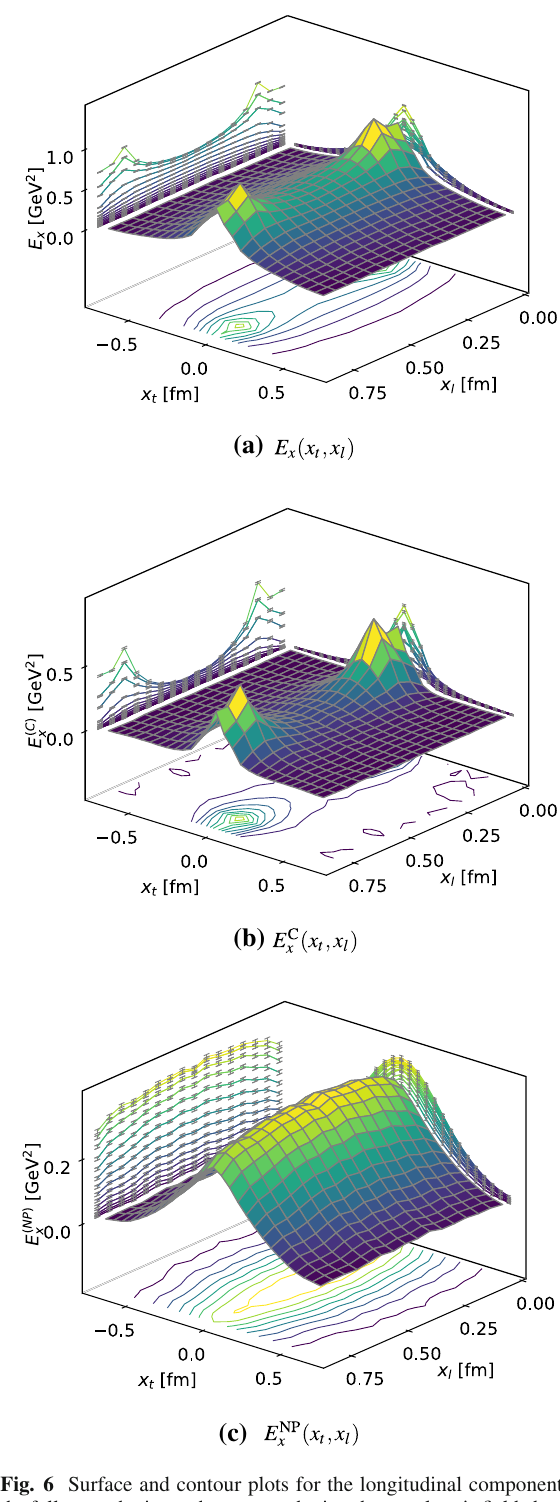
Fig. 6 Surface and contour plots for the longitudinal components of thefull,perturbativeandnon-perturbativechromoelectricfieldobtained by using the curl procedure at β = 6 . 370 and d = 0 . 85 fm. All plotted quantities are in physical